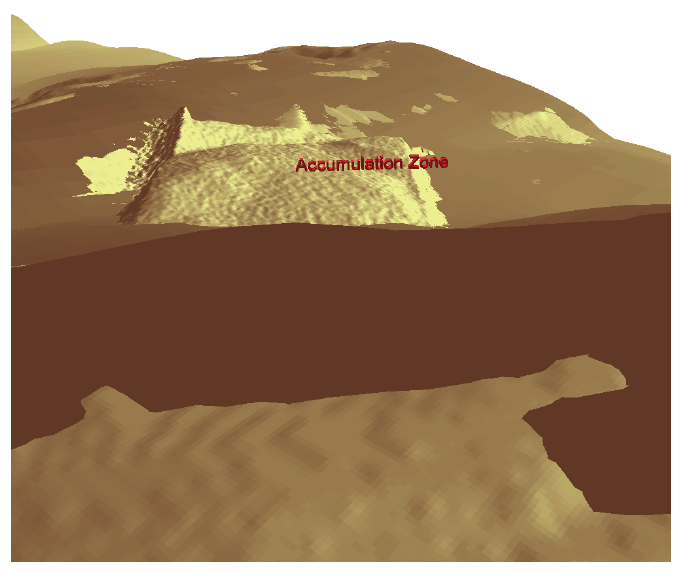
Figure 12. Shaded relief representation (view from the ridge) of the landslide simulation on subject Light Detection and Ranging (LiDAR) data: before ( left ) and after ( right ).